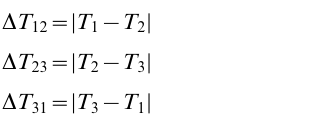
Figure 1. Representation of QF FINAL using Eq. (7) to determine whether or not a data product is valid.